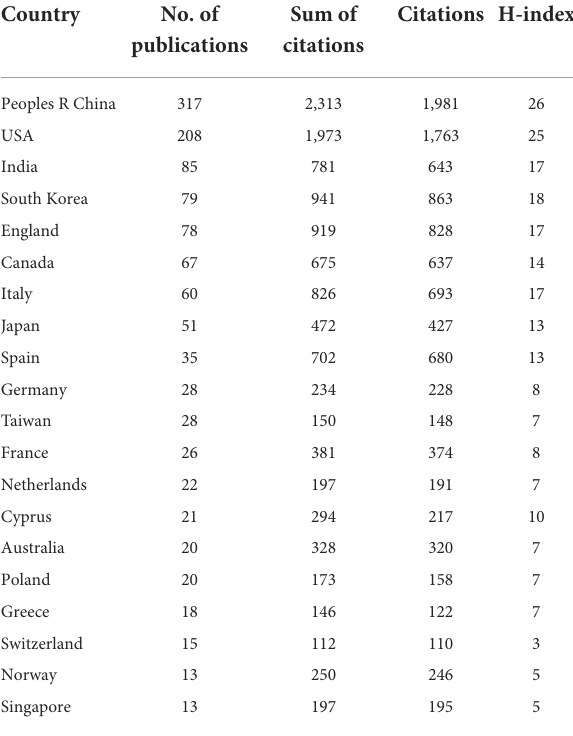
TABLE 1 Top 20 countries with the highest global contributions related to the use of AI in ultrasound. Country No. of Sum of citations